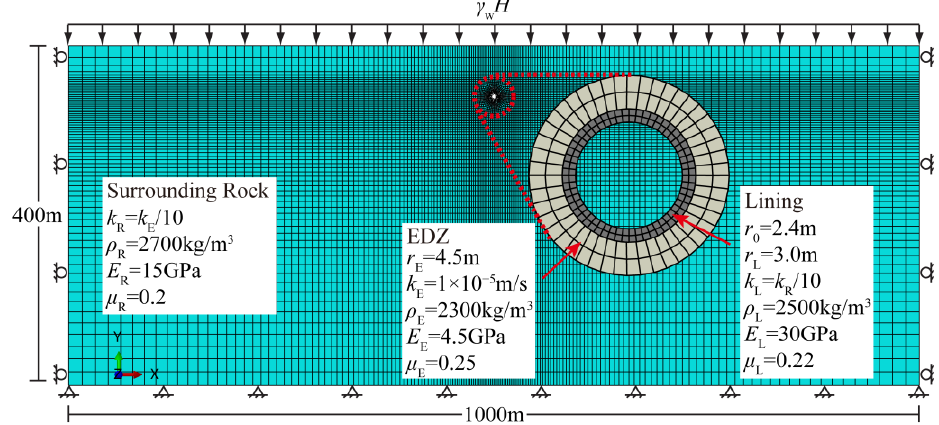
Figure 2. Difference among analytical solutions with different h / r E in various H / r E and k R / k L values. ( a ) H / r E = 10, k R / k L = 100; ( b ) H / r E = 0, k R / k L = 100; ( c ) H / r E = 10, k R / k L = 10; ( d ) H / r E = 0, k R / k L = 10.